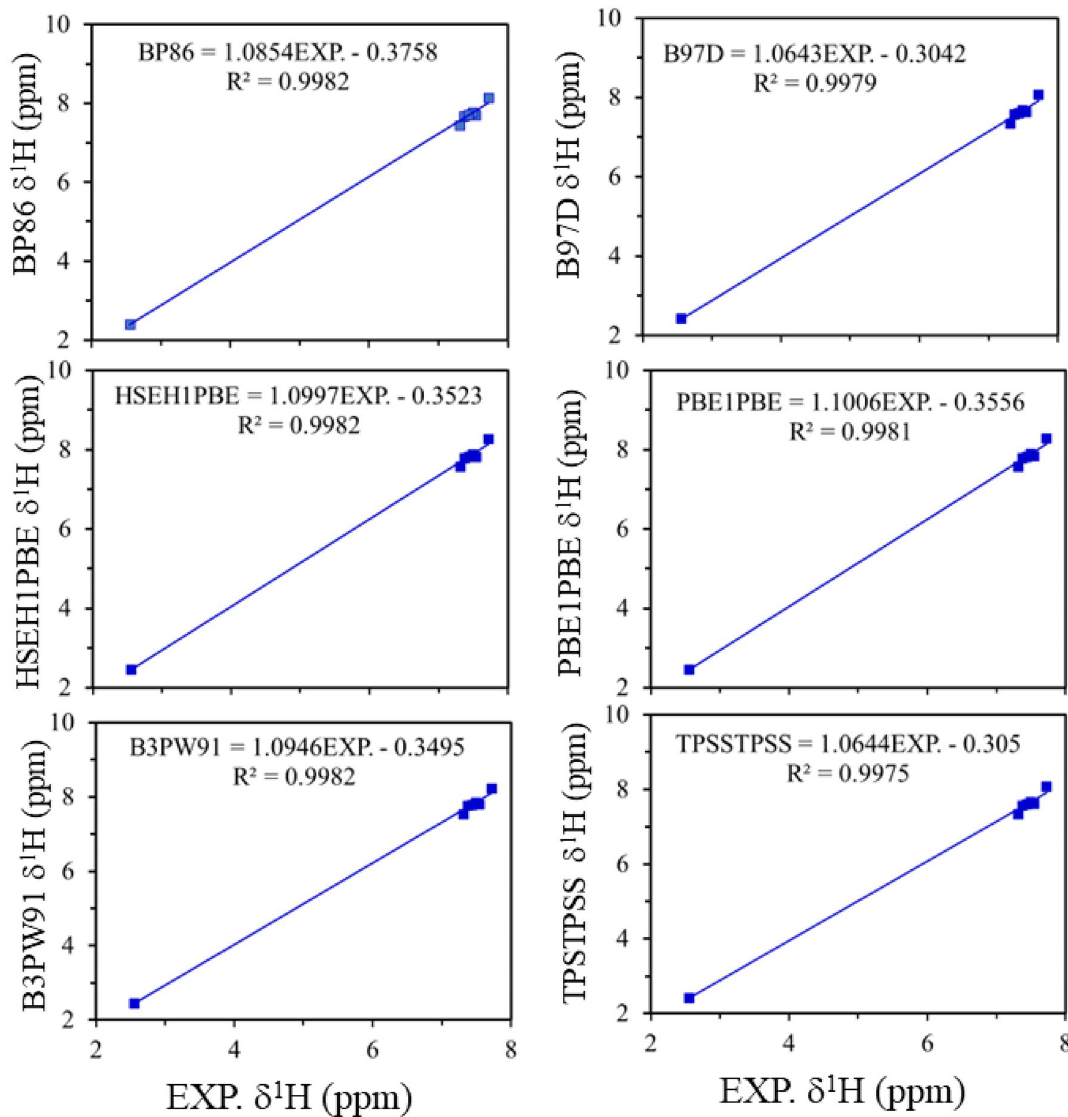
Figure 2. Correlation between the experimental 1 H-NMR chemical shifts and the computed 1 H-NMR chemical shifts as calculated using six different DFT methods (BP86, B97D, HSEH1PBE, PBE1PBE, B3PW91, and TPSSTPSS) with TZVP basis set at the B3LYP/TZVP geometry ( TBT